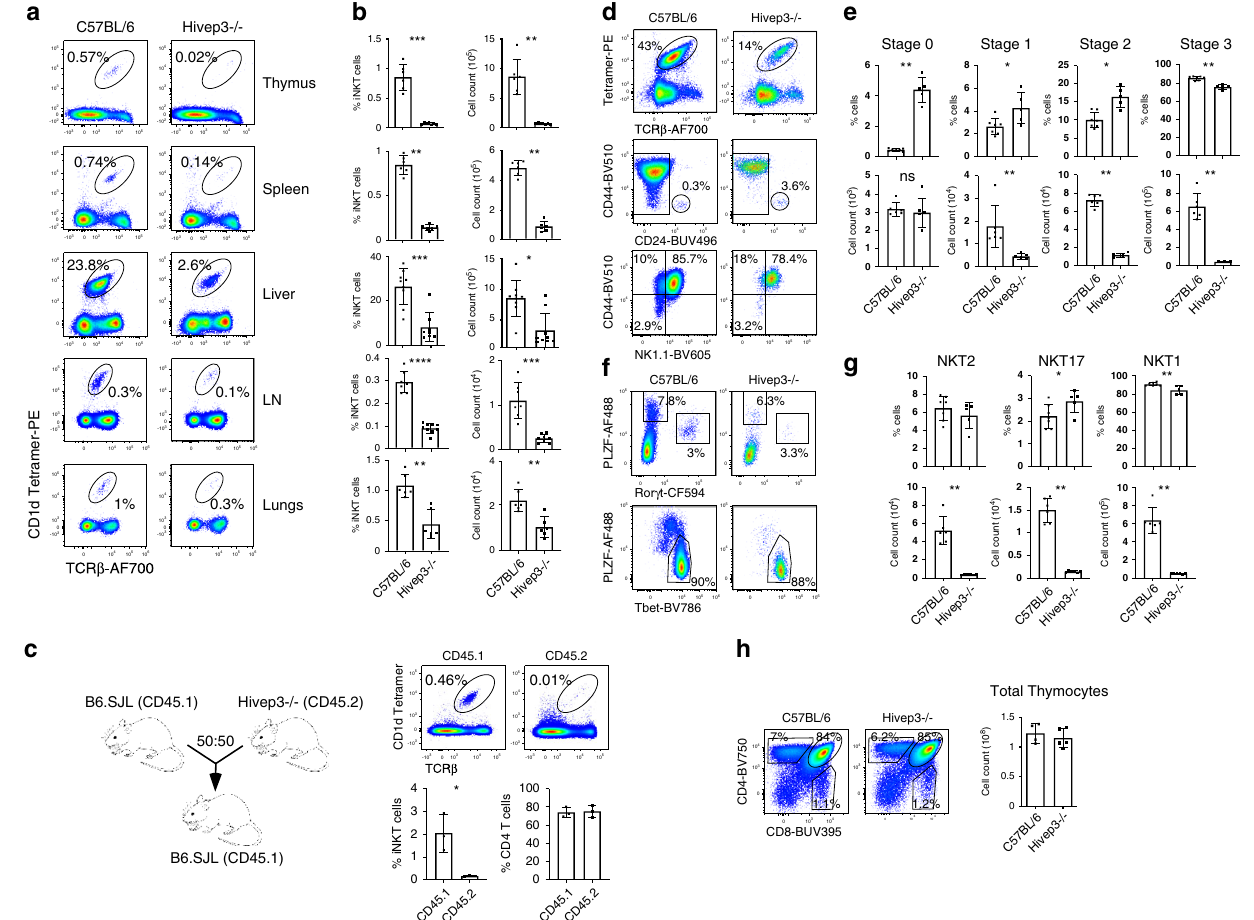
Fig. 4 Intrinsic de fi ciency of iNKT cells in Hivep3 − / − mice. a iNKT cell proportions in C57BL/6 and Hivep3 − / − mice were identi fi ed in the indicated tissues by staining with PBS57-CD1d tetramers and an antibody targeting TCR β . For the lung and liver samples, cells were fi rst gated on viability dye negative, CD45 + and CD19 − cells, while for the other organs cells were gated on viability dye negative cells. b Quanti fi ed iNKT cell proportions and numbers in C57BL/6 and Hivep3 − / − mice in each of the indicated tissues. Data are from 3 independent experiments with 6 thymus, 6 spleen, 8 liver, 7 lymph node and 6 lung tissues analyzed from C57BL/6 mice and 7 thymus, 6 spleen, 9 liver, 8 lymph node and 7 lung tissues analyzed from Hivep3 − / − mice. Thymus p = 0.0006 and p = 0.0012, Spleen p = 0.022 and p = 0.022, Liver p = 0.0003 and p = 0.0111, LN p < 0.0001 and p = 0.002, Lungs p = 0.022 and p = 0.043 for p ercentages and absolute numbers, respectively. c Left , Cartoon depicting the competitive bone marrow chimera strategy in which CD45.1 C57BL/6 bone marrow was mixed at a 50:50 ratio with CD45.2 Hivep3 − / − bone marrow and subsequently transferred into irradiated CD45.1 recipient mice. Right , iNKT and single positive CD4 + T cell proportions were quanti fi ed from both C57BL/6 (CD45.1) and Hivep3 − / − (CD45.2) mice after immune reconstitution. Data are from one experiment with 3 mice per condition. d – g Data are from 2 independent experiments with a total of 7 C57BL/6 and 5 Hivep3 − / − mice. iNKT cells from C57BL/6 and Hivep3 − / − mice were categorized based on expression of CD24, CD44, NK1.1 into stage 0, stage 1, stage 2 and stage 3 and subsequently quanti fi ed for their relative proportions and numbers. Stage 0 p = 0.0025 and p = 0.9, Stage 1 p = 0.048 and p = 0.0027, Stage 2 p = 0.01 and p = 0.0025, Stage 3 p = 0.0025 and p = 0.0023 for percentages and absolute numbers, respectively ( d , e ) and also categorized based on expression of PLZF, Ror γ t and T-bet into iNKT1, iNKT2 and iNKT17 and subsequently quanti fi ed for their relative proportions and numbers iNKT1 p = 0.0025 and p = 0.0025, iNKT2 p = 0.3434 and p = 0.0027, iNKT17 p = 0.046 and p = 0.0025 for percentages and absolute numbers, respectively ( f , g ). h Left , Flow cytometry analysis depicting DP, CD4 and CD8 proportions in WT and KO mice. Right , Histograms quantifying total thymic cellularity. Data are from 2 independent experiments with a total of 4 C57BL/6 and 5 Hivep3 − / − mice. Data in the fi gure are mean ± SD with dots representing individual values. Source data are provided as a source data fi